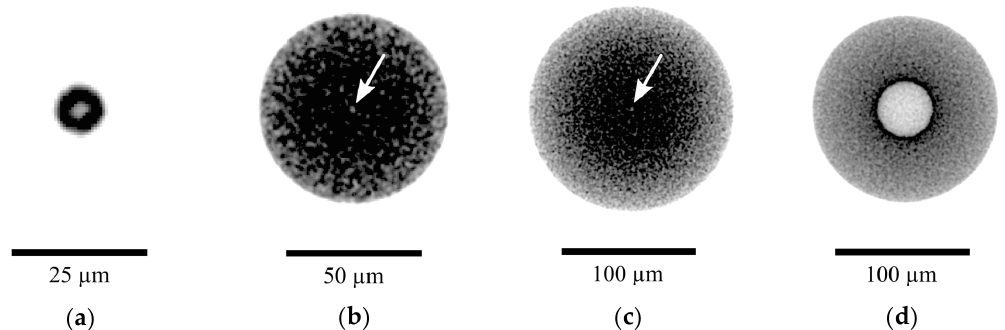
Figure 7. Simulated radiographs (GV max = 4200) of different particle and pore diameters. The images were filtered, and the contrast was optimized for printed paper. ( a – c ) The smallest detectable pores for a particle diameter of ( a ) 10 µ m, ( b ) 70 µ m, and ( c ) 150 µ m. Image ( d ) covers a particle diameter of 135 µ m and a pore diameter of 40 µ m, which is in the range of the particle and pore sizes found in the experiment (see Section 3.3). White arrows in ( b , c ) point to the centered pore. All images are in correspondence with the values listed in Table